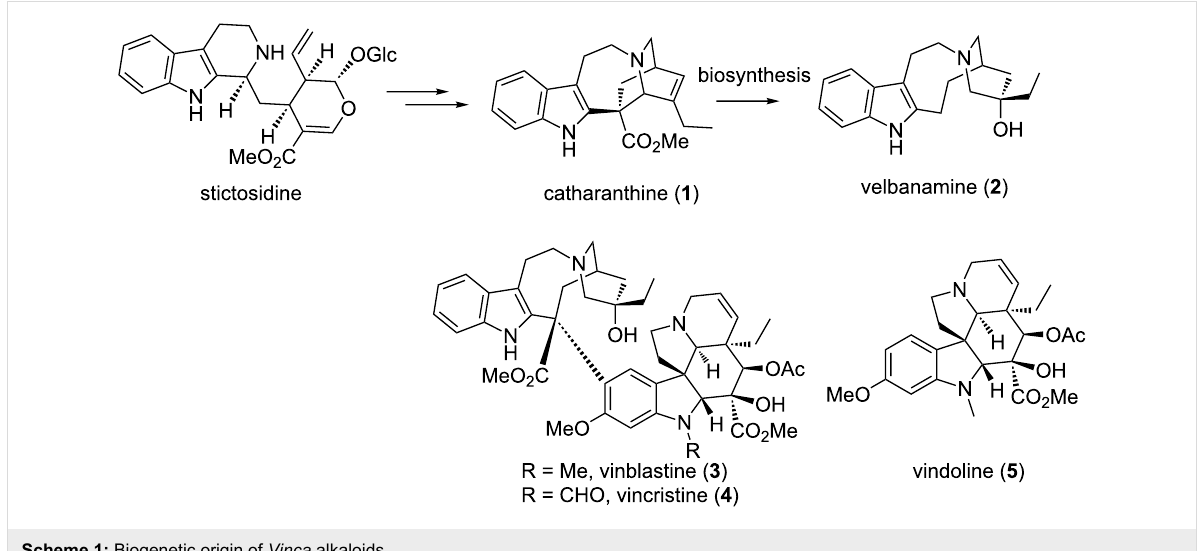
Scheme 1: Biogenetic origin of Vinca alkaloids.